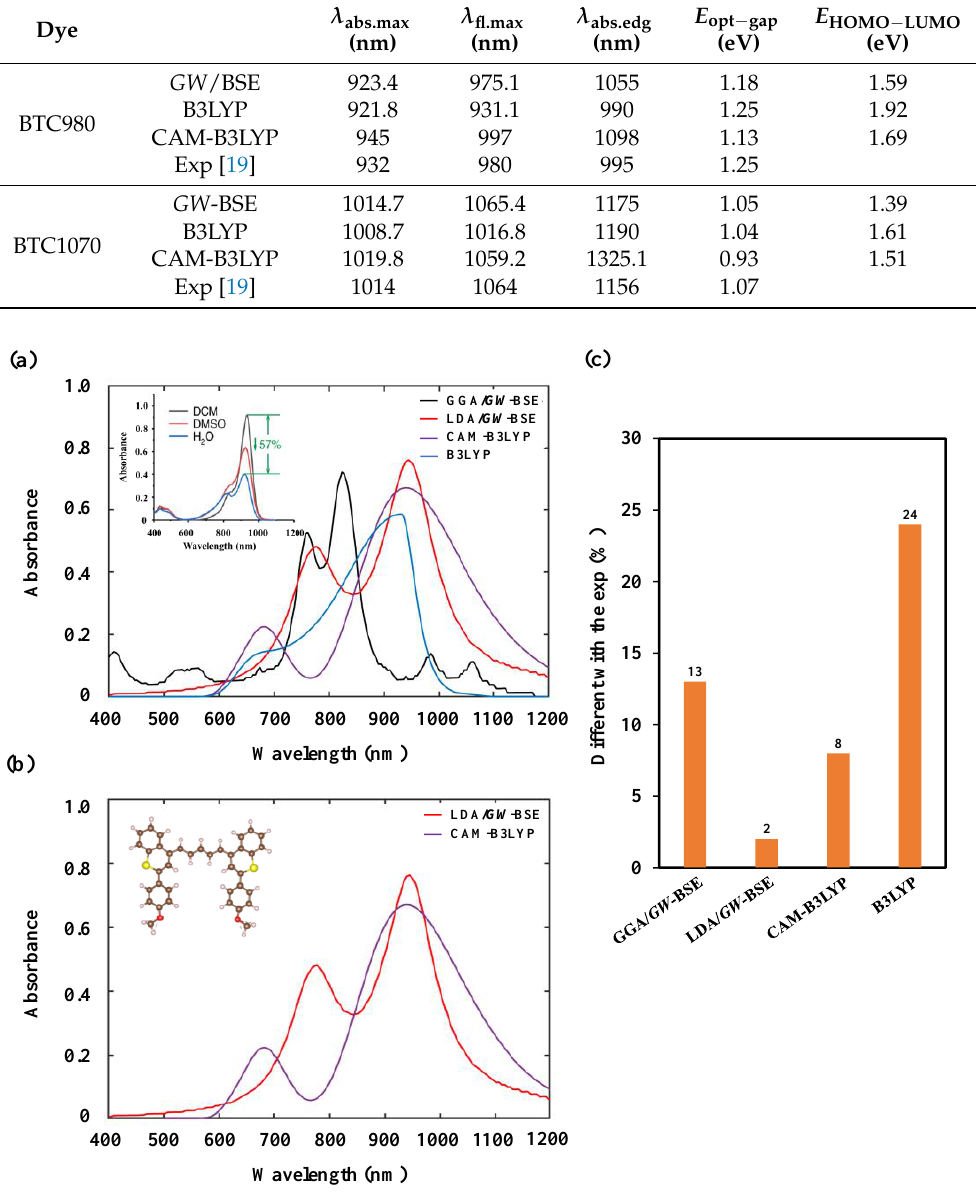
Figure 2. The UV/VIS absorption spectra of BTC980 under ( a ) GW -BSE within the VASP package, and the standard hybrid (B3LYP) and long-range corrected hybrid (CAM-B3LYP) within the Gaussian package. ( b ) The best absorption spectra match the experiment. ( c ) The difference value of the vertical theoretical absorption wavelength ( 𝜆 𝑣𝑒𝑟𝑡−𝑎𝑏𝑠 ) and the experimental wavelength ( 𝜆 𝑒𝑥𝑝−𝑎𝑏𝑠 ) , ∆ 𝜆 (𝑛𝑚) = 𝜆 𝑒𝑥𝑝−𝑎𝑏𝑠 − 𝜆 𝑣𝑒𝑟𝑡−𝑎𝑏𝑠 . The inset in Figure 2a: the absorption spectra of BTC980 from the experiment [19].